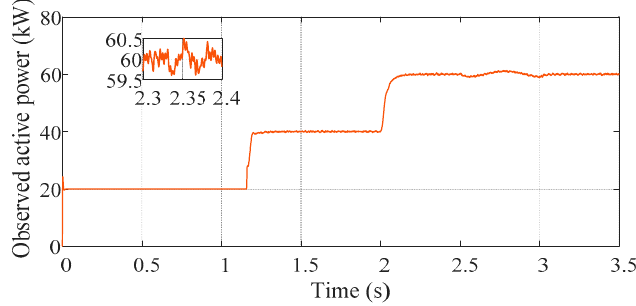
Figure 26. Output power observed by linear extended state observer (LESO).